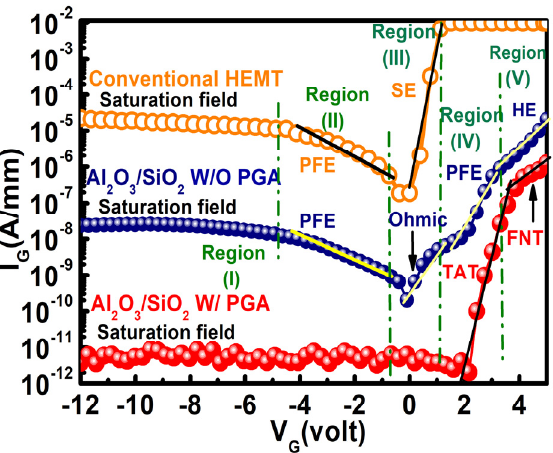
Figure 7. Gate leakage characteristics of the Al 2 O 3 /SiO 2 MOS–HEMT with and without PGA treatment and conventional HEMT without PGA treatment.